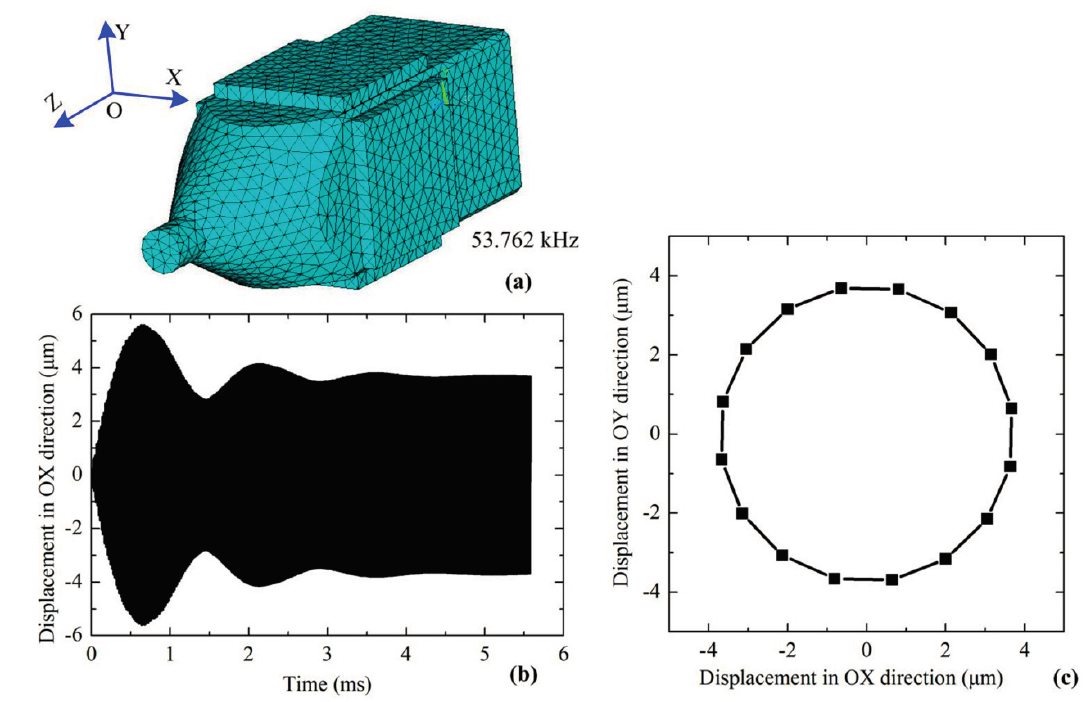
Figure 5. Movement of the end tip by transient analysis: ( a ) FEM model of the transducer; ( b ) the displacement response of the driving tip along OX direction; ( c ) the steady motion of the driving tip in XOY plane.